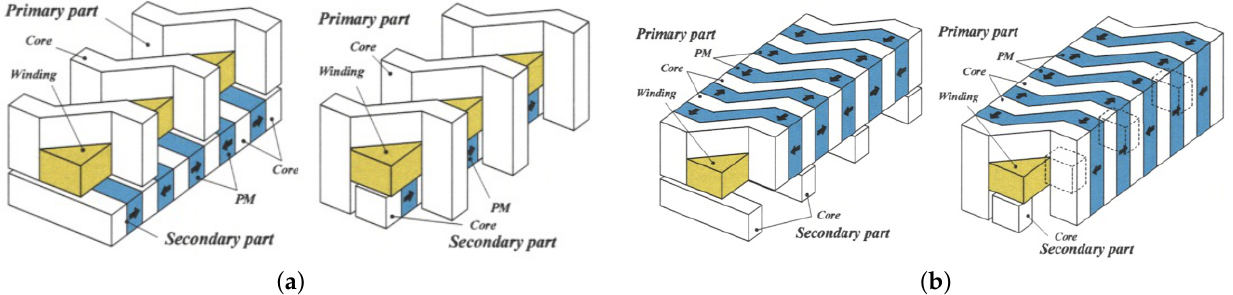
Figure 15. Transverse flux permanent magnet synchronous generators [145]. ( a ) Inner rotor. ( b ) Outer